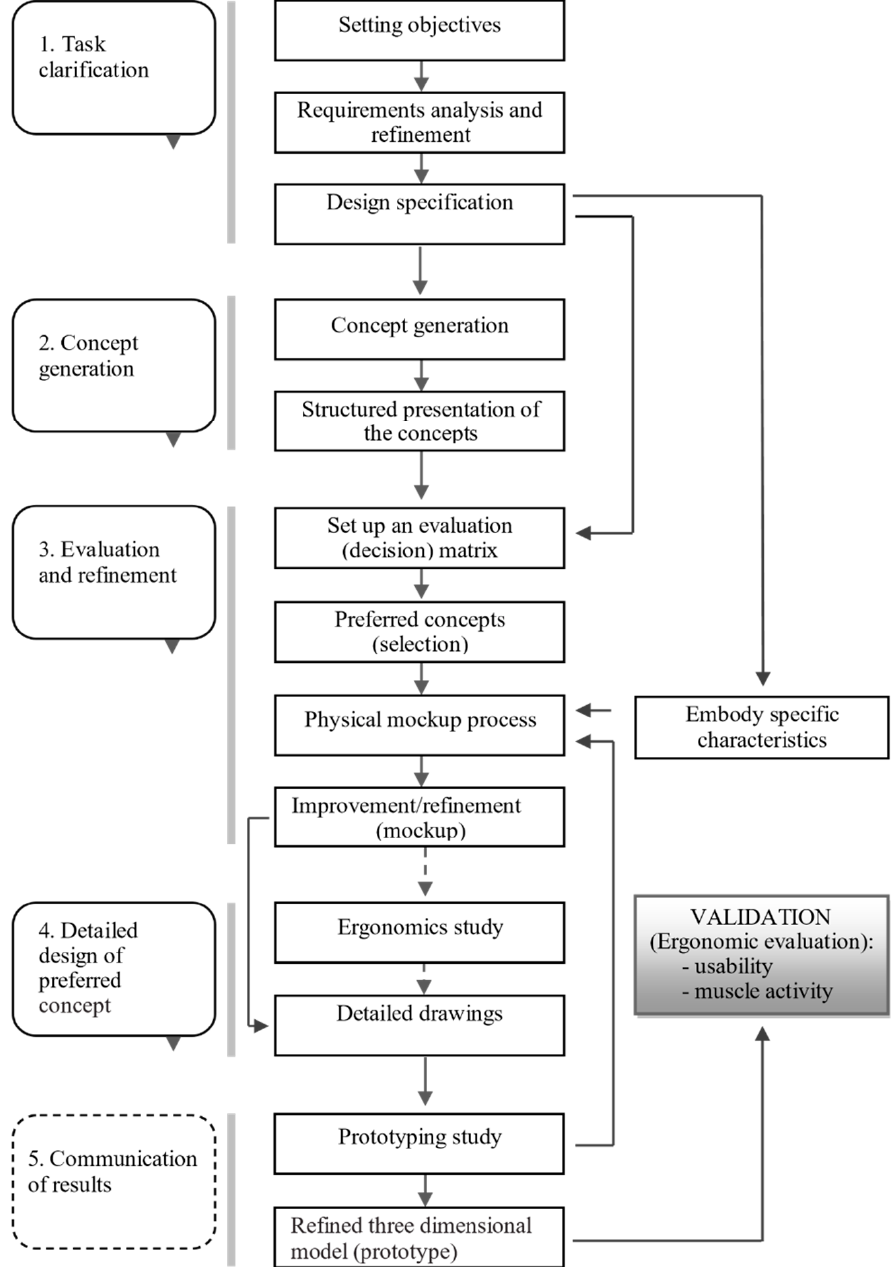
Figure 1. Process flow diagram of the operational model adopted in computer mice geometry development (adapted from Lewis and Bonollo [11], Hales